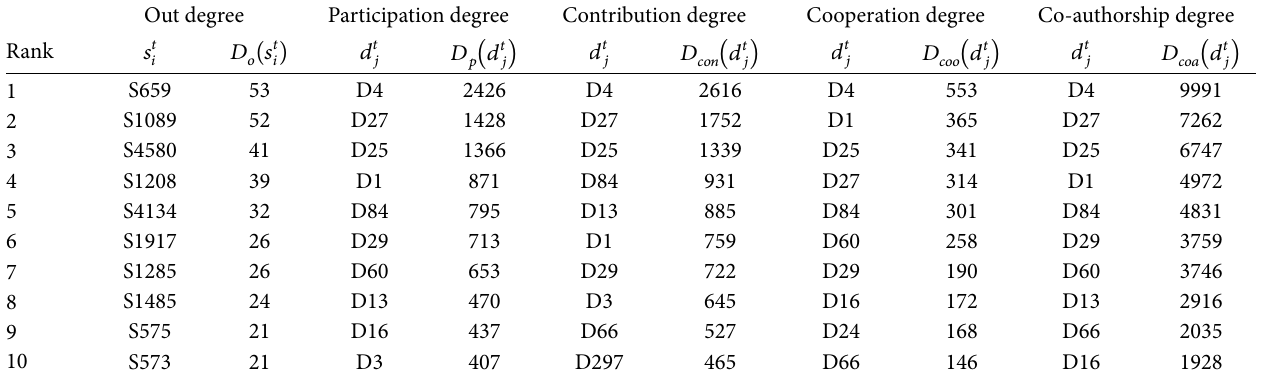
Table 5: The top ten standards and drafters in high indicators till